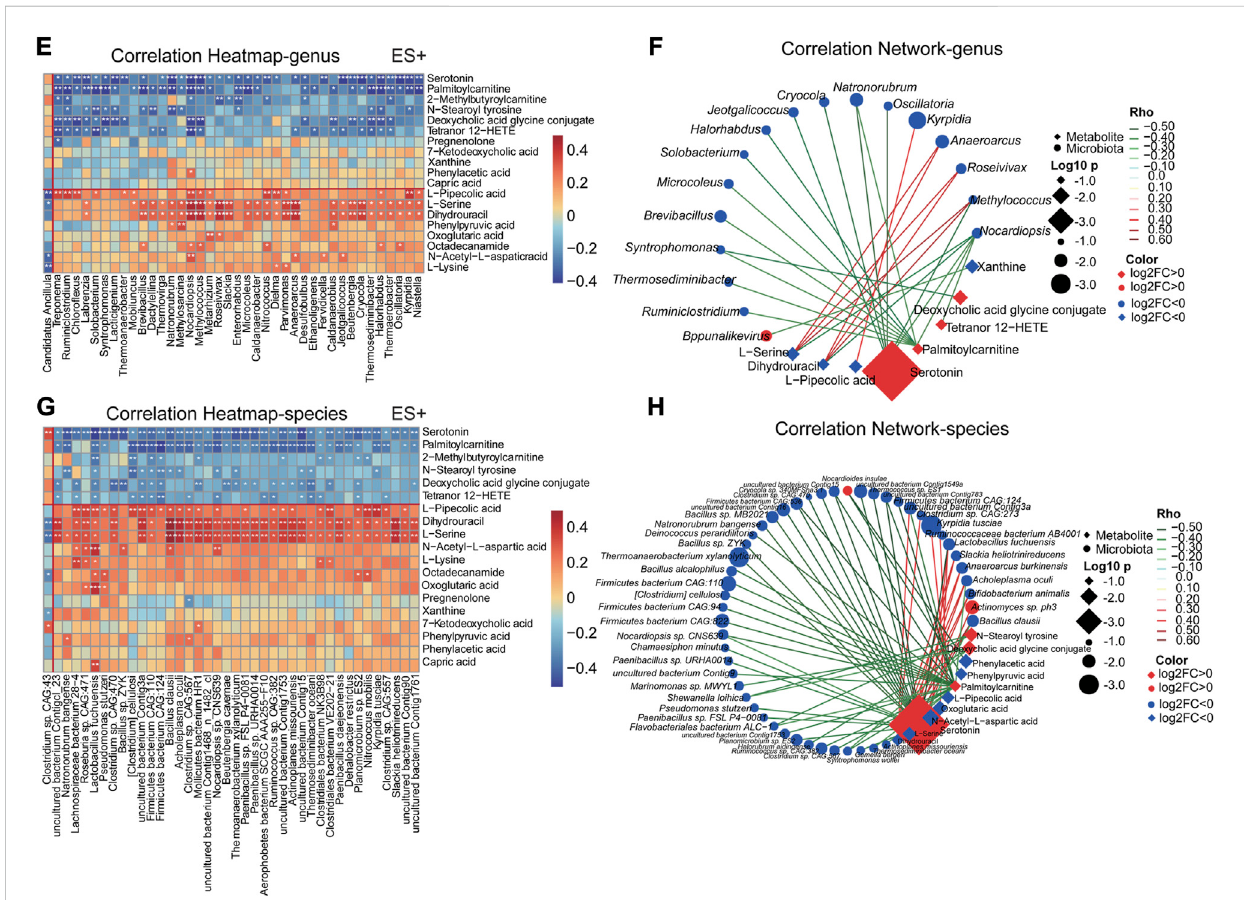
FIGURE 5 (Contiuned). Smoking HTN-associated serum metabolites correlated with gut microbial genera and species differentiating HTN-S vs HTN-NS individuals. (A, C, E, G) , The association of gut microbial genera and species with top 40 serum metabolites in the study cohort was described with heatmap. The genera, species and metabolites included were those identi fi ed as signi fi cantly disparate between HTN-S vs. HTN-NS samples. A is for correlation of genera and metabolites, and C is association of species with metabolites, respectively. Positive associations are in red, and negative associations are in blue. * p < 0.05, ** p < 0.01, and *** p < 0.001, Spearman ’ s rank correlation. (B, D, F, H) , Correlation network was produced based on integration of microbiome and metabolome datasets. Differential microbial variances were highly linked with differential metabolites. The correlation coeffcient is ≥ 0.4or ≤ − 0.4,and p < 0.05, calculatedfromSpearmancorrelation. Color ofthenodeshasbeenupdatedtorepresent log2FC,anddifferent datatypeformetabolite/clinical/microbesisdenotedwiththenodeshape.Log10 p -valuesisdescribedwithnodesizetohighlightthemajorcorrelations, and spearman Rho was displayed using continuous scaling of coloring of the edges. The datatype was used for attribute circular layout to group each